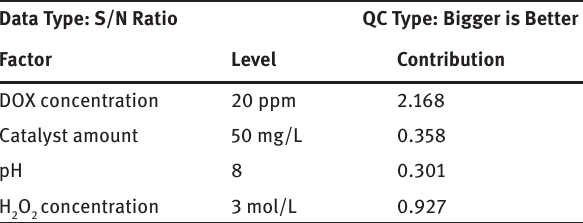
Data Type: S/N Ratio